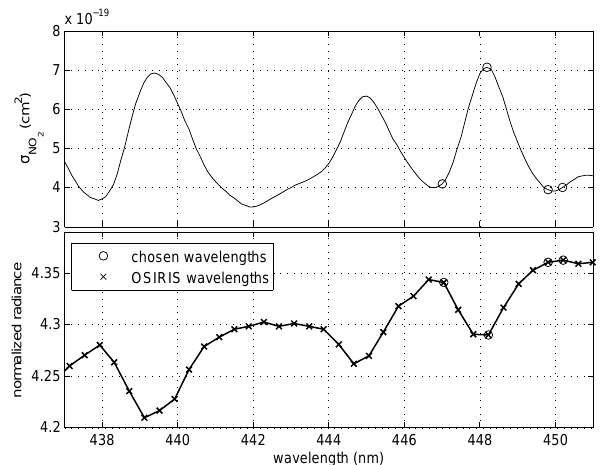
Fig. 1. The NO 2 cross section and the measured OSIRIS spectrum in the wavelength range from 437nm to 451nm. The 4 wavelengths used in this technique are indicated with circle markers at the long wavelength end. The lower panel shows an OSIRIS 23km tangent altitude spectrum in the same wavelength range after it has been nor- malized by the OSIRIS spectrum measured along a 45km tangent altitude line of sight. OSIRIS pixels are indicated with x